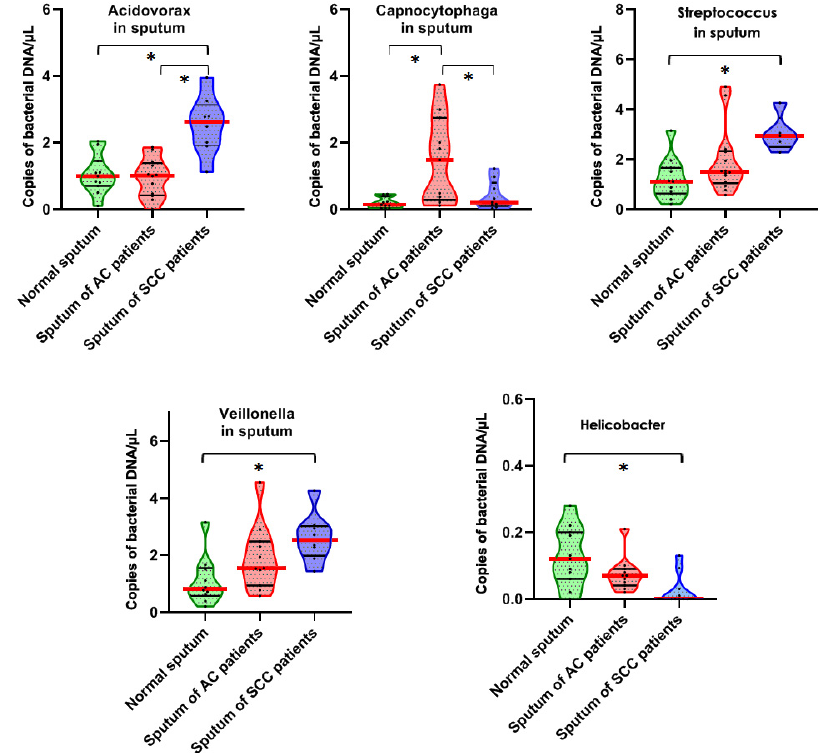
Figure 2. Five bacterial genera show different abundances in sputum of lung AS or SCC patients and cancer-free individuals. The solid red line indicates median, while the black line indicates quartiles of abundance (copies of bacterial DNA/µl) of each genera in the specimens. *, p < 0.05 determined by a Mann–Whitney U test).